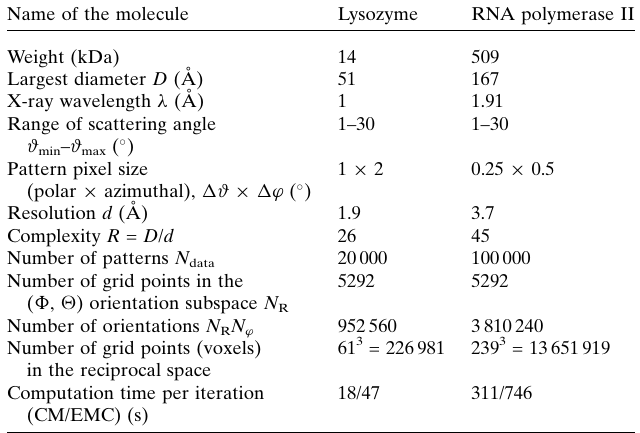
Table 1 Parameters of the test molecules, the simulations and the orientation processes.